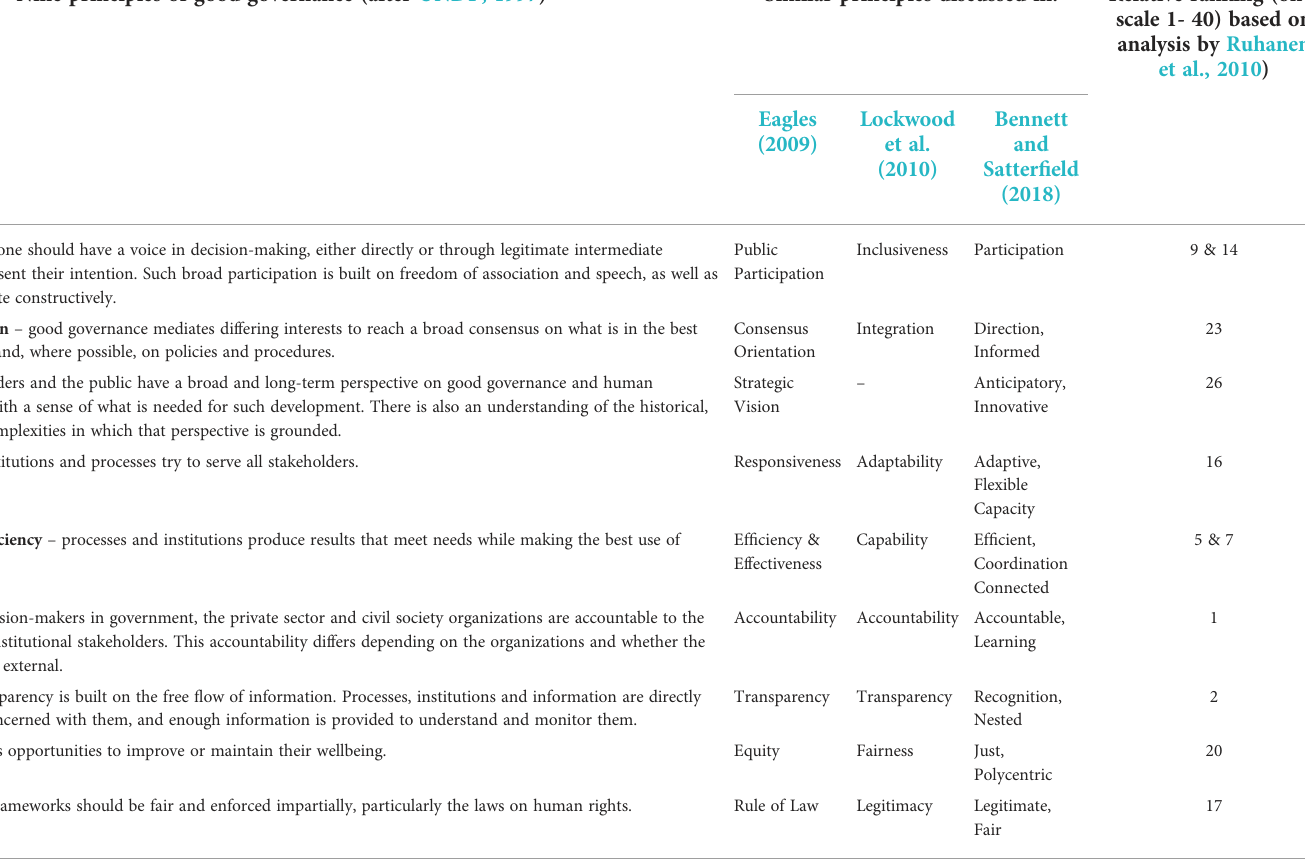
TABLE 1 Nine key principles of good governance [after UNDP (1997) and adapted by Graham et al. (2003) ]. Groupings of principles from Graham et al.